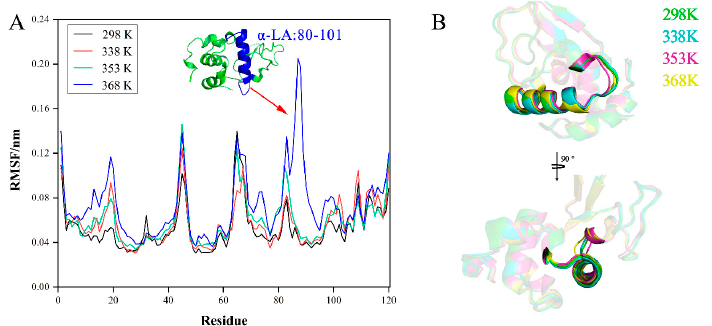
Figure 5. MD simulates the differences of α -LA in different temperature environments, and ( A ) Rg plot and ( B ) RMSD plot.